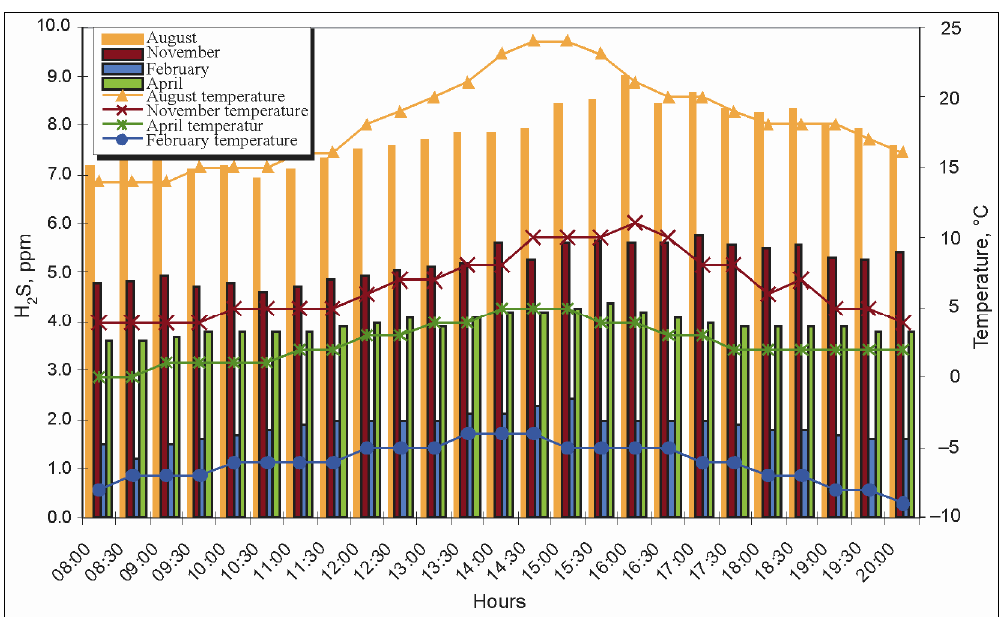
Fig. 11. H 2 S change during the day (point No.